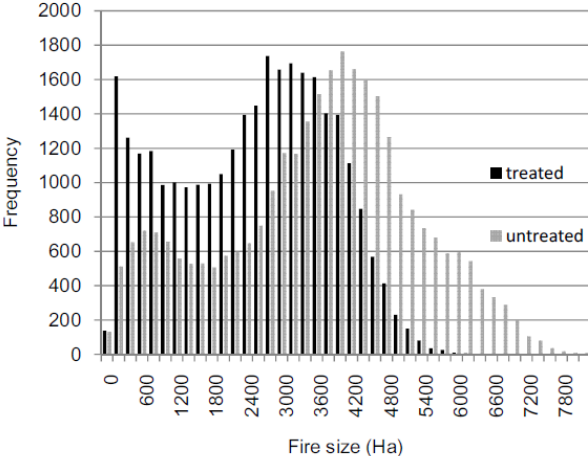
Fig. 4. Frequency histogram of fire size (ha) for the 30000 simu- lated wildfires for the non-treatment and treatment